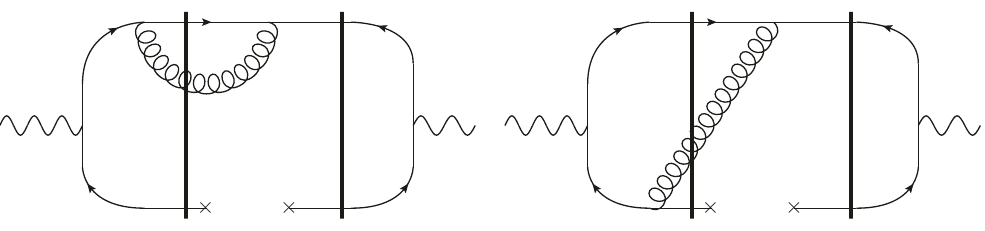
Figure 4 . Here the left diagram is σ 1 × 3 and σ 5 , and the right diagram is σ 1 × 4 and σ 7 . The ‘x’ indicates the produced